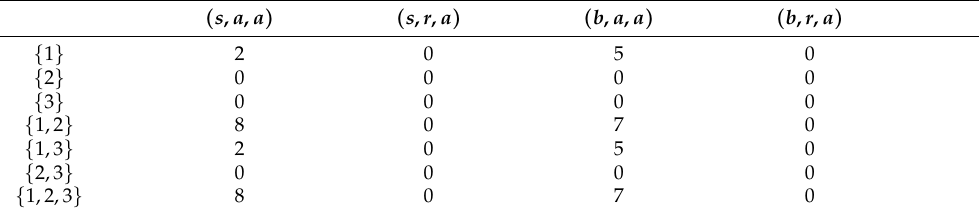
Table 11. The coalitions’ utilities of the branded ingredient